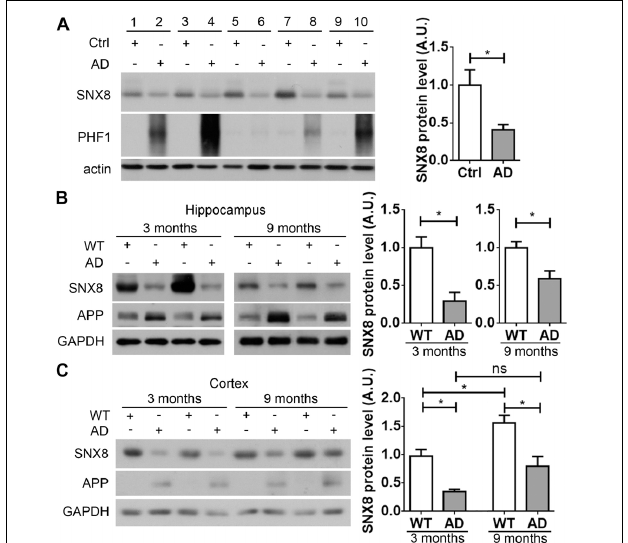
FIGURE 1 | SNX8 levels are reduced in human AD and APP/PS1 AD mouse brain. (A) Equal protein quantities in lysates from paired AD patient brains (AD) and age- and sex-matched non-dementia controls (Ctrl) were subjected to Western blotting with antibodies to detect SNX8, phosphorylated tau (PHF1) and β -actin. SNX8 protein intensities were quantified by densitometry, and normalized to respective controls (set to 1.0), n = 5, ∗ p < 0.05, Mann–Whitney U test. (B,C) Equal protein quantities of lysates from hippocampal (B) or cortical (C) tissues of APP/PS1 AD mice and wild type (WT) littermates at 3 and 9 months of age were subjected to Western blotting with antibodies against SNX8, APP (the 369 antibody recognizing both mouse and human APP was used in B ; the 6E10 antibody recognizing human APP only was used in C ) and GAPDH. SNX8 protein intensities were quantified by densitometry, and normalized to respective controls (set to 1.0), n = 4, ∗ p < 0.05, Mann–Whitney U